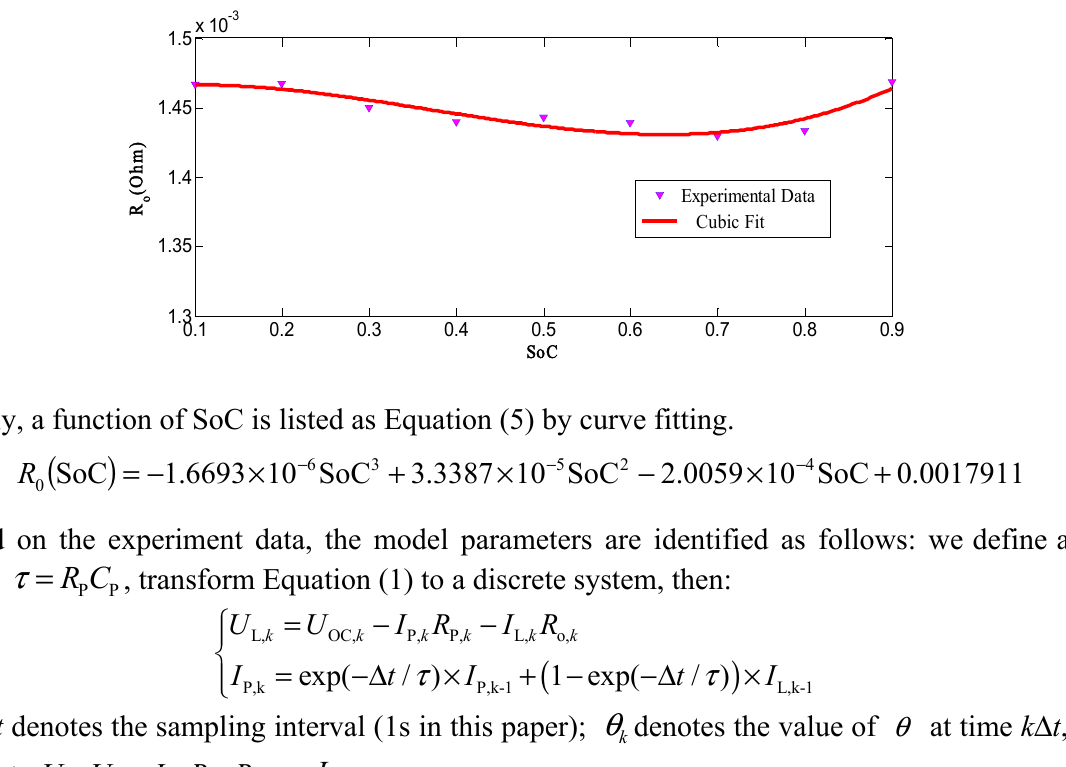
Figure 4. The Ohmic resistance experimental data and curve fitting